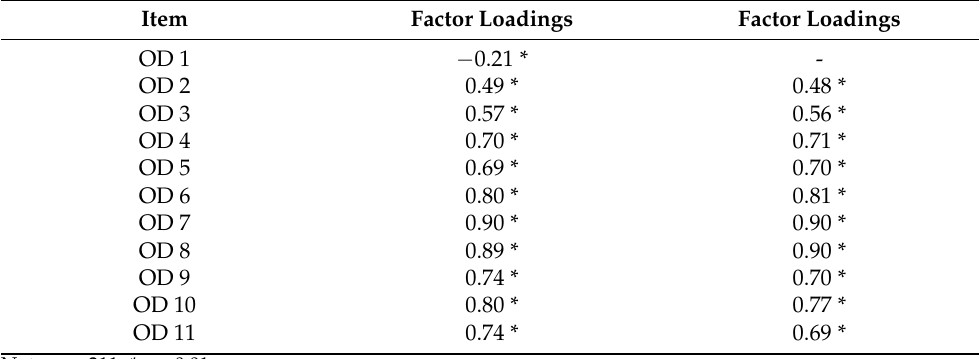
Table 3. EFA factor loadings for 11 and 10 items. Item